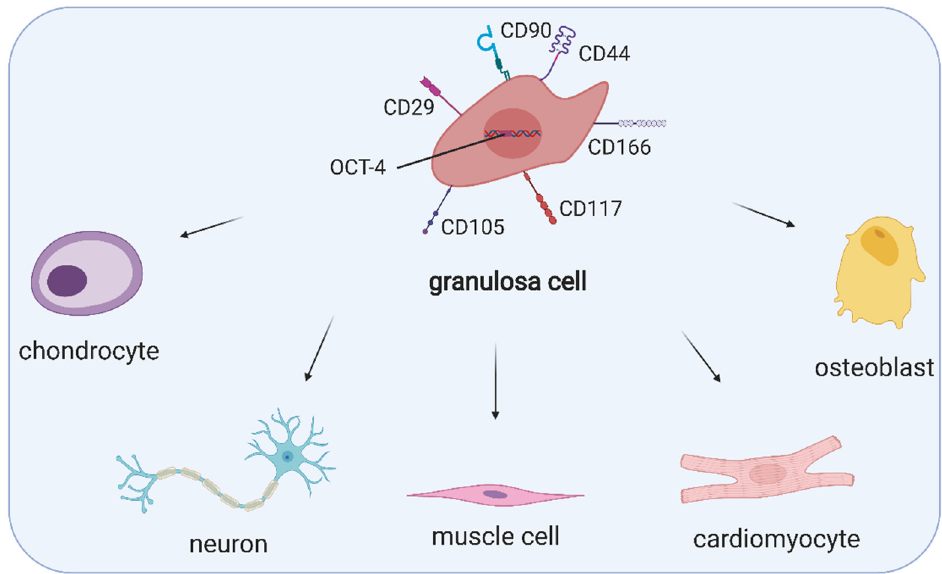
Figure 1. Expression of MSC- and stemness-specific markers, namely CD90, CD44, CD166, CD117, CD105, CD29 and OCT-4 as well as the multipotency of granulosa cells. (Created with BioRen- der.com, accession date: